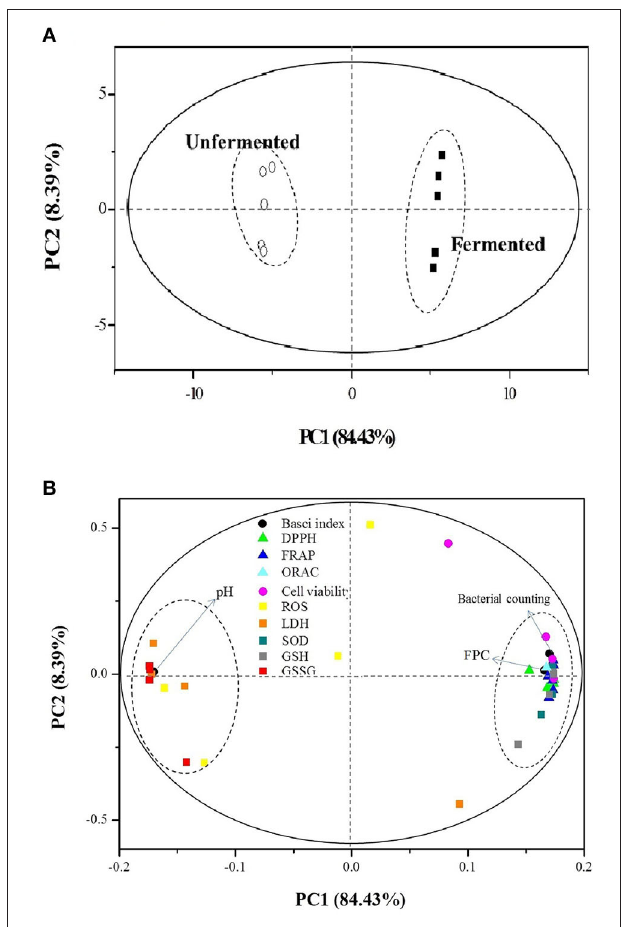
FIGURE 4 | Plots of (A) sample scores and (B) parameter loadings of principal component analysis (PCA) involving 12 variables on UF-BPE and F-BPE.